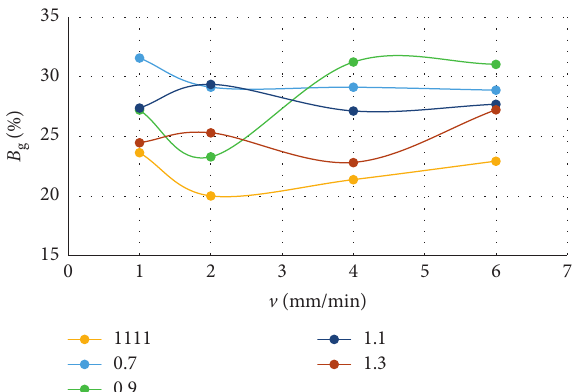
Figure 8: The relationship between the loading speed and the particle breakage of samples. Table 4: The expressions of particle breakage. Samples